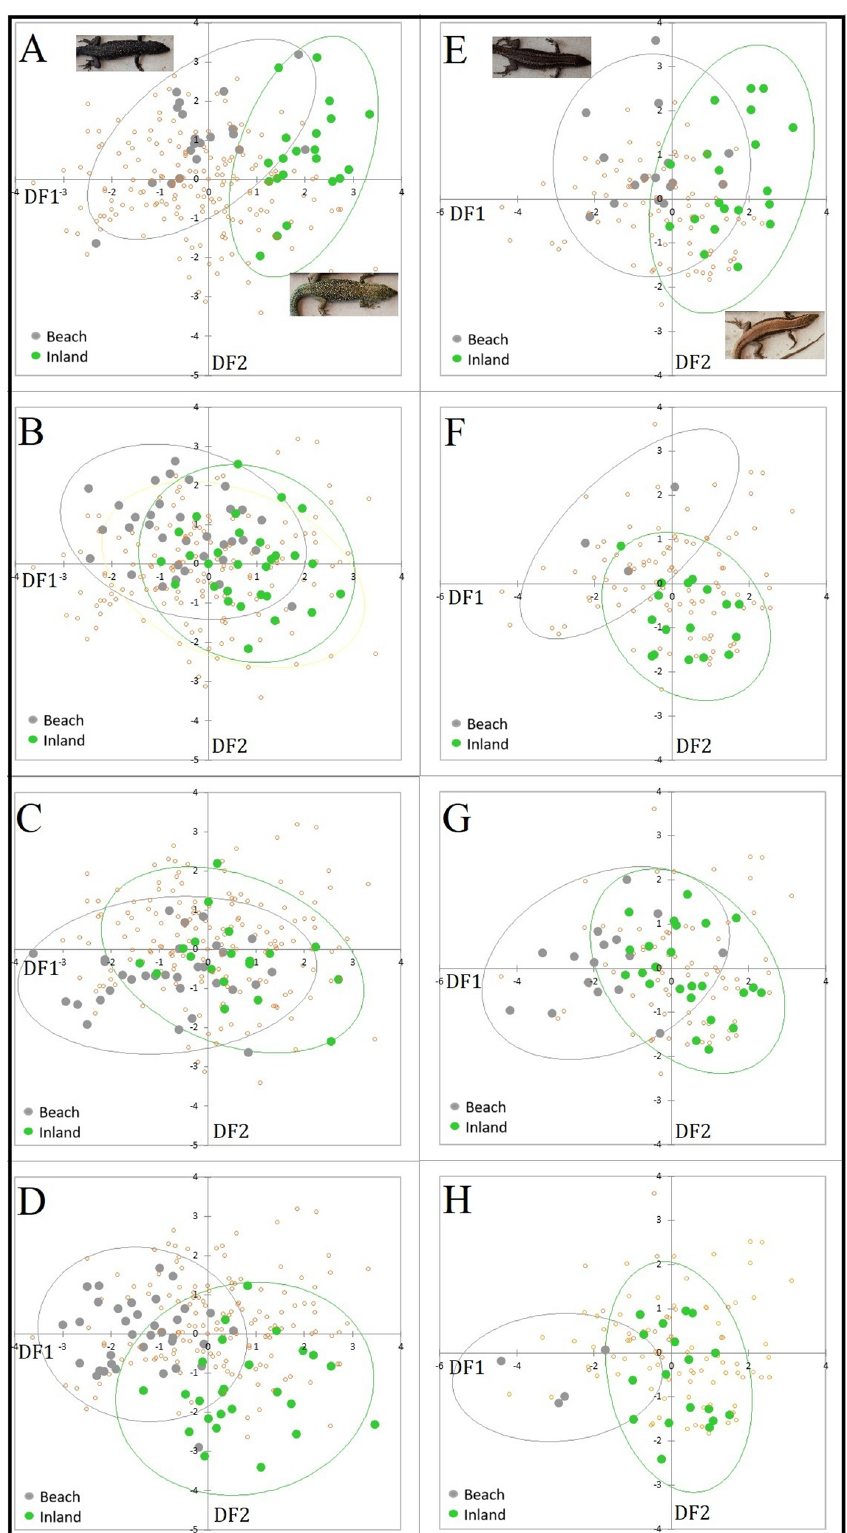
Fig. 1 Lizard luminance. Plots of scores from the male ( A – D ) and female ( E – H ) discriminant function analyses (DFA) of luminance, with 95% con fi dence ellipses. For males, DF1 and DF2 represented 55.7 and 28.6% of the variation; corresponding values for females were 65.8 and 15.4%, respectively. While the DFAs were carried out across all eight sites, just the scores for matched pairs of beach and inland sites are emphasized in each separate plot for clarity: plots A and E correspond to locality 1, plots B and F to locality 2, C and E to locality 3, and D and H to locality 4. Additional, transparent points on each plot show scores for individuals from other sites. Inset photographs in the uppermost Fig. A , E show representative inland and beach individuals, which were similar at all localities. Sample sizes are given in Supplementary Table